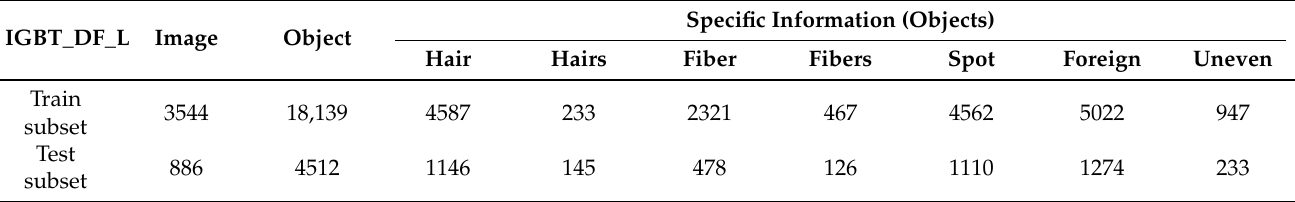
Table A3. The specific information of IGBT_DF_L